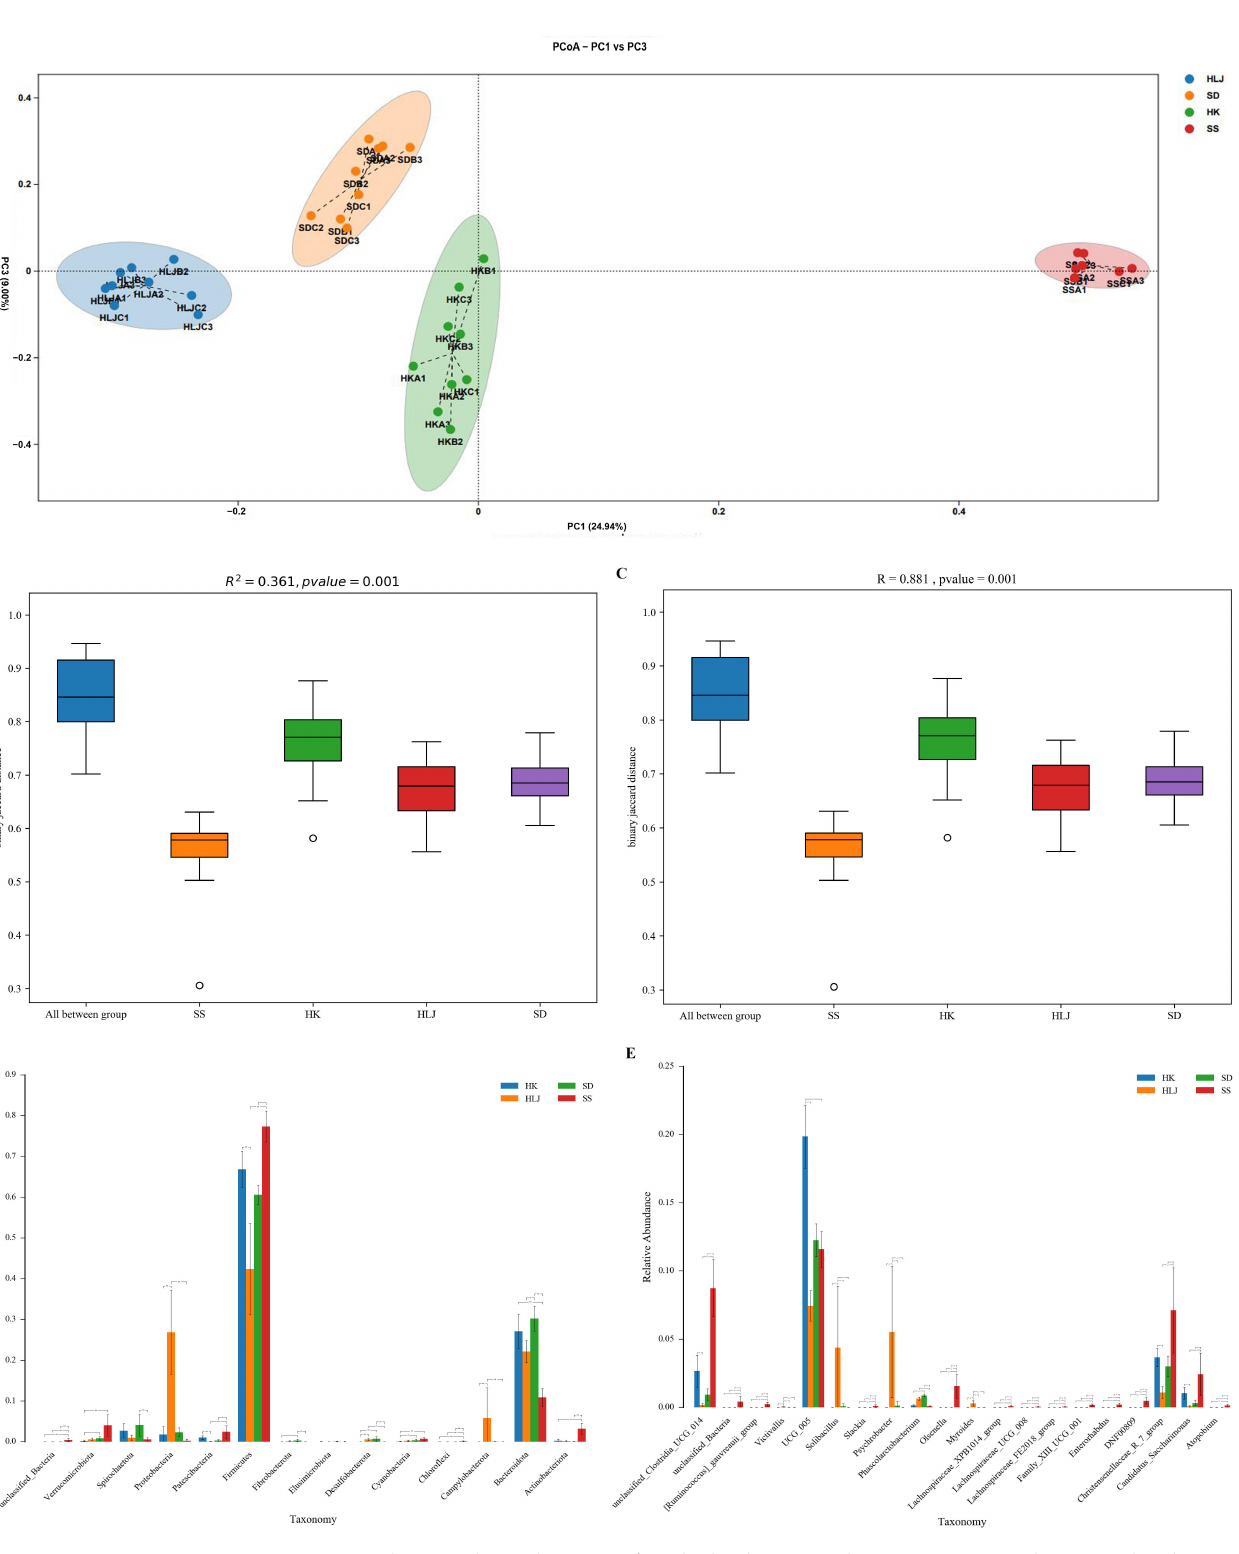
Figure 2. The microbiota diversity of cattle display an evident association with geographical position. ( A ) Beta diversity analysis shows the sequential association of microbiota diversity among the sampled locations in the dimension of PC1. ( B , C ) the distant separations among the four locations are confirmed using the methods of PERMANOVA and ANOSIM, respectively. ( D , E ) Kruskal–Wallis rank sum test further analyzes the statistical significance of microbiome partitions above at the phylum and genus levels. Data are expressed as mean ± standard deviation. * p < 0.05, ** p <